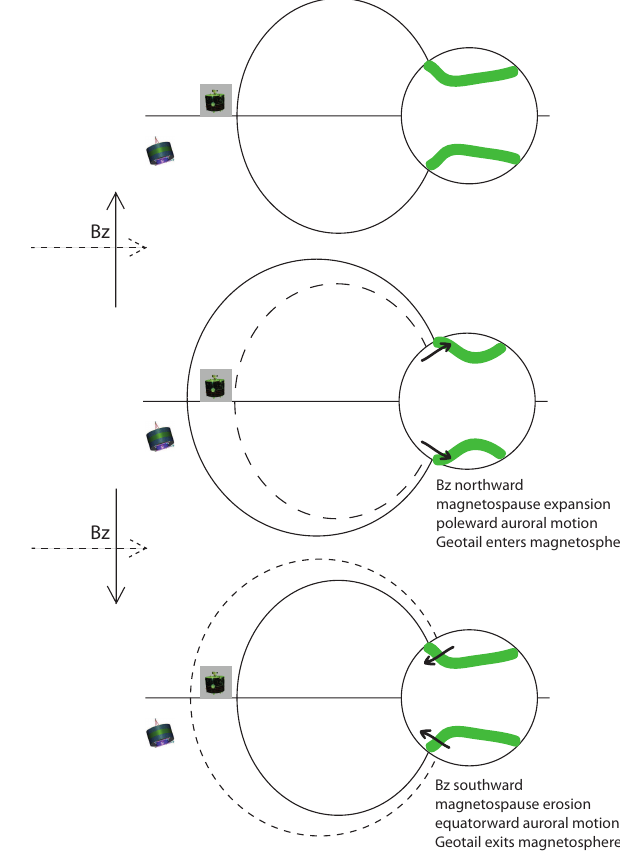
Fig. 6. (A) The south-polar keograms for 4278 and 6300 ˚A. (B) Geotail B z , black markings show intervals that the spacecraft is in the magnetosphere. (C) TC1 B z , with arrows pointing from B z = 0 crossing to change in aurora behaviour. The vertical green and pink lines show the start and end of the poleward motion of the aurora, respectively.